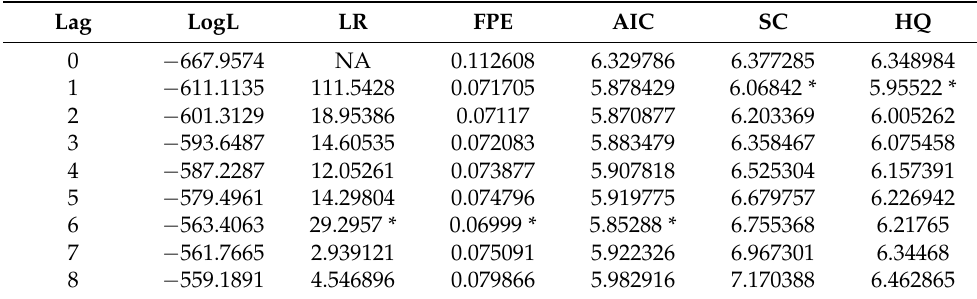
Table 8. Lag length criteria: GPR Saudi Arabia, FSI, and